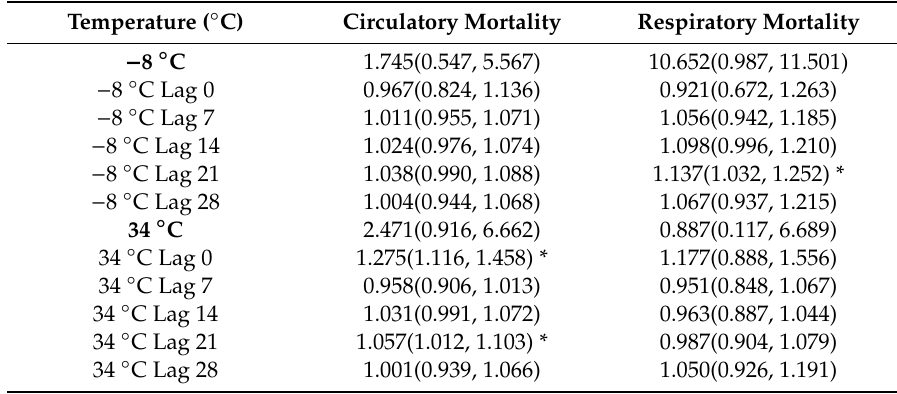
Table 6. Temperature e ff ects at the minimum ( − 8 ◦ C) and maximum (34 ◦ C) average